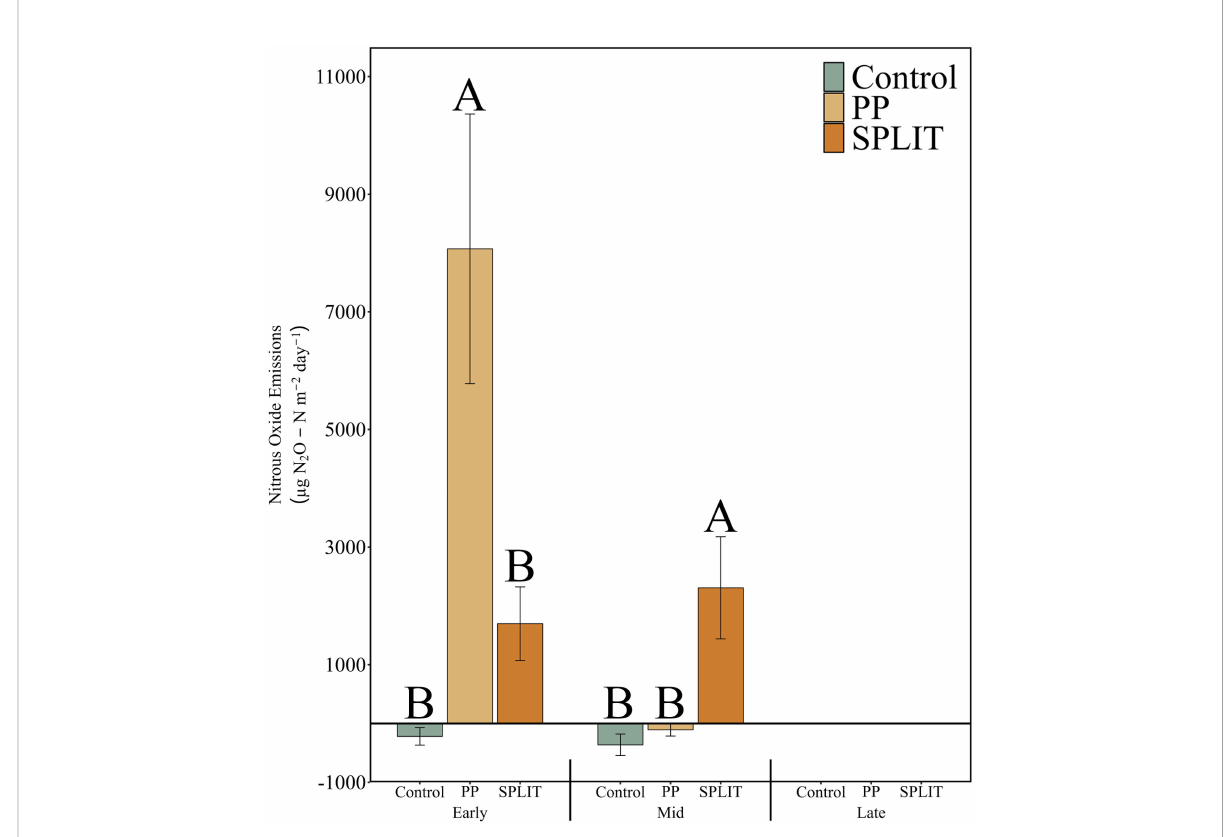
(Table 2). The model generated for prediction of pore-space NO performed poorly compared to N 2 O with an R 2 of 0.20 (Figure 5). The model coef fi cients for pore-space NO included GWC and AOB abundance (Table